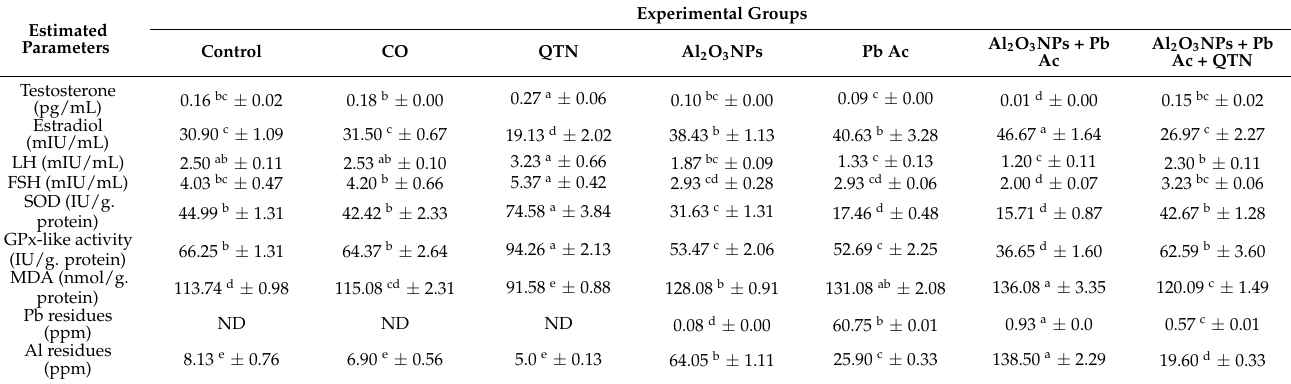
Table 2. Effect of quercetin (QTN) on serum levels of male hormones and oxidative stress indicators and testicular tissue content of lead (Pb) and aluminum (Al) of adult male Sprague Dawley rats exposed to aluminum trioxide nanoparticles (Al 2 O 3 NPs) and/or lead acetate (Pb Ac) for 60